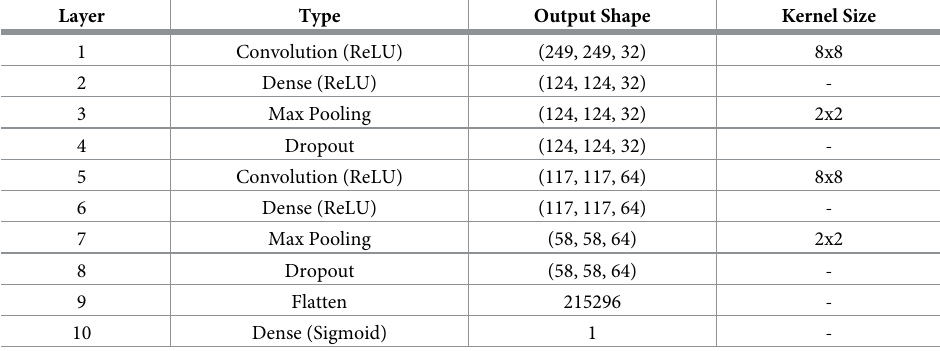
Table 2. CNN model structure for the tumor detection model with input